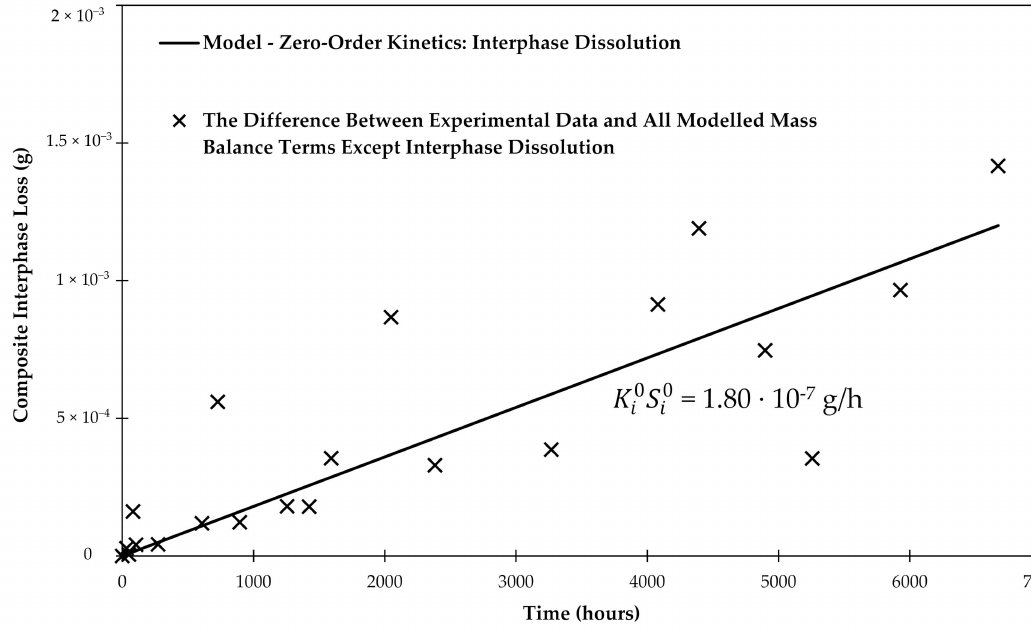
Figure 9. Linear regression of the di ff erence between the experimental data and the all modelled terms except the interphase. The regressed line provides insight about the rate of the composite interphase dissolution in